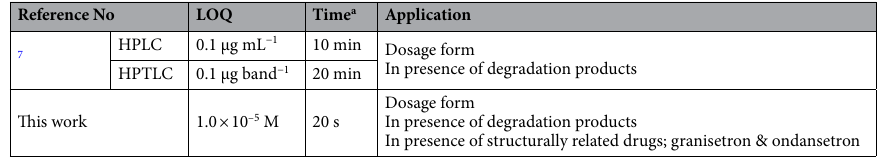
Table 4. An overview on the reported stability-indicating chromatographic methods compared to the proposed potentiometric method for the determination of PALO. a Time required for acquiring data from one sample